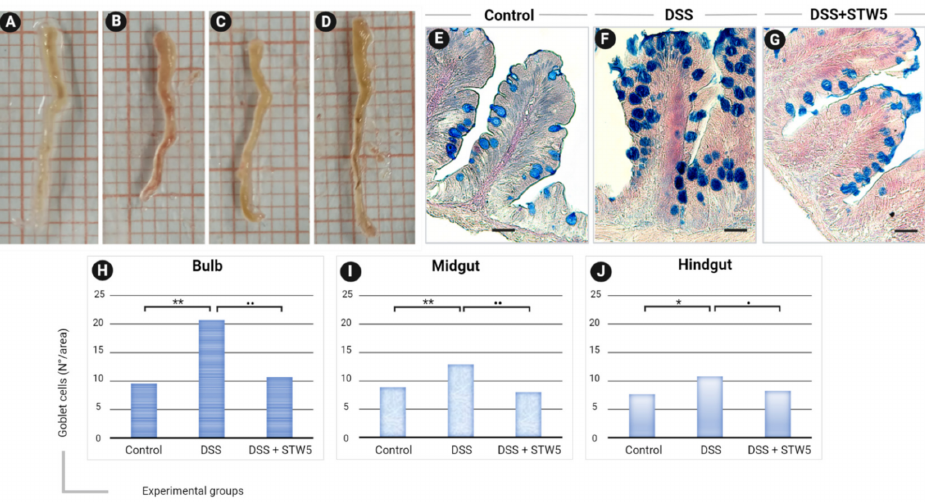
Figure 1. Macroscopic features of gut explants from zebrafish under ( A ) resting conditions, ( B ) after 8 h of treatment with 0.5% dextran sodium sulfate (DSS), ( C ) after 16 h of treatment with 0.12 mg/Ml STW 5, and ( D ) after DSS + STW 5 treatment. ( E – G ) Tissue sections of zebrafish gut (bulb) stained with Alcian blue showing the distribution and density of goblet cells (blue) under resting conditions, DSS- or DSS+STW5-treatment. ( H – J ) Relative number of goblet cells in bulb, midgut, and hindgut explants. The quantification was performed using five different slides of each part of the intestine from three animals ( n = 15 sections total for bulb, midgut, and hindgut). Data are expressed as the mean number of goblet cells ± standard deviation (SD). Statistical significance was calculated using the Wilcoxon test comparing DSS-treated or DSS+STW 5–treated samples with controls. * p ≤